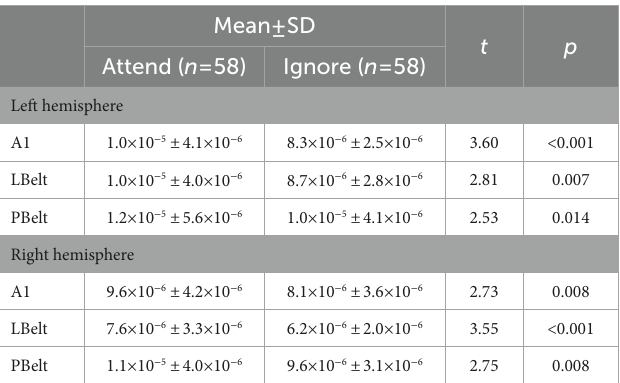
TABLE 2 Phase-amplitude coupling in auditory cortex.